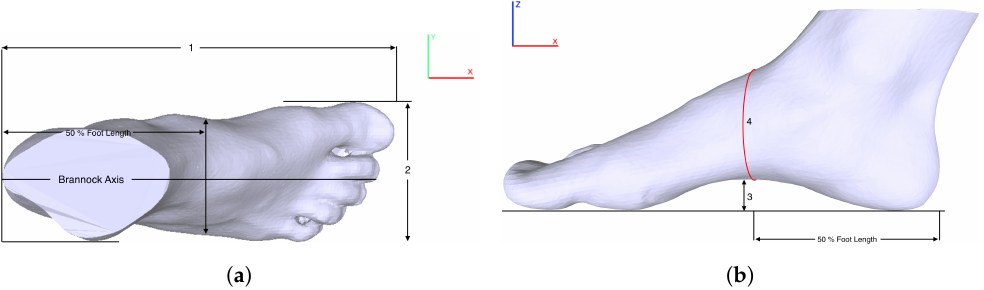
Figure 1. Foot dimensions. ( a ) Top view—foot length and width are marked as 1 and 2, respectively; ( b ) side view—arch height and instep girth are marked as 3 and 4,